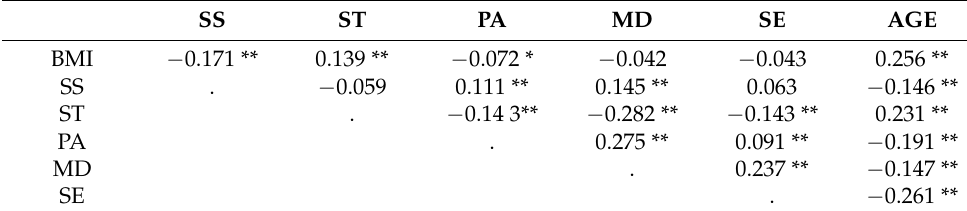
Table 3. Sex-adjusted correlations between study variables. SS ST PA MD SE AGE BMI − 0.171 ** 0.139 ** − 0.072 * − 0.042 − 0.043 0.256 ** SS . − 0.059 0.111 ** 0.145 ** 0.063 − 0.146 ** ST . − 0.14 3** − 0.282 ** − 0.143 ** 0.231 ** PA . 0.275 ** 0.091 ** − 0.191 ** MD . 0.237 ** − 0.147 ** SE . − 0.261